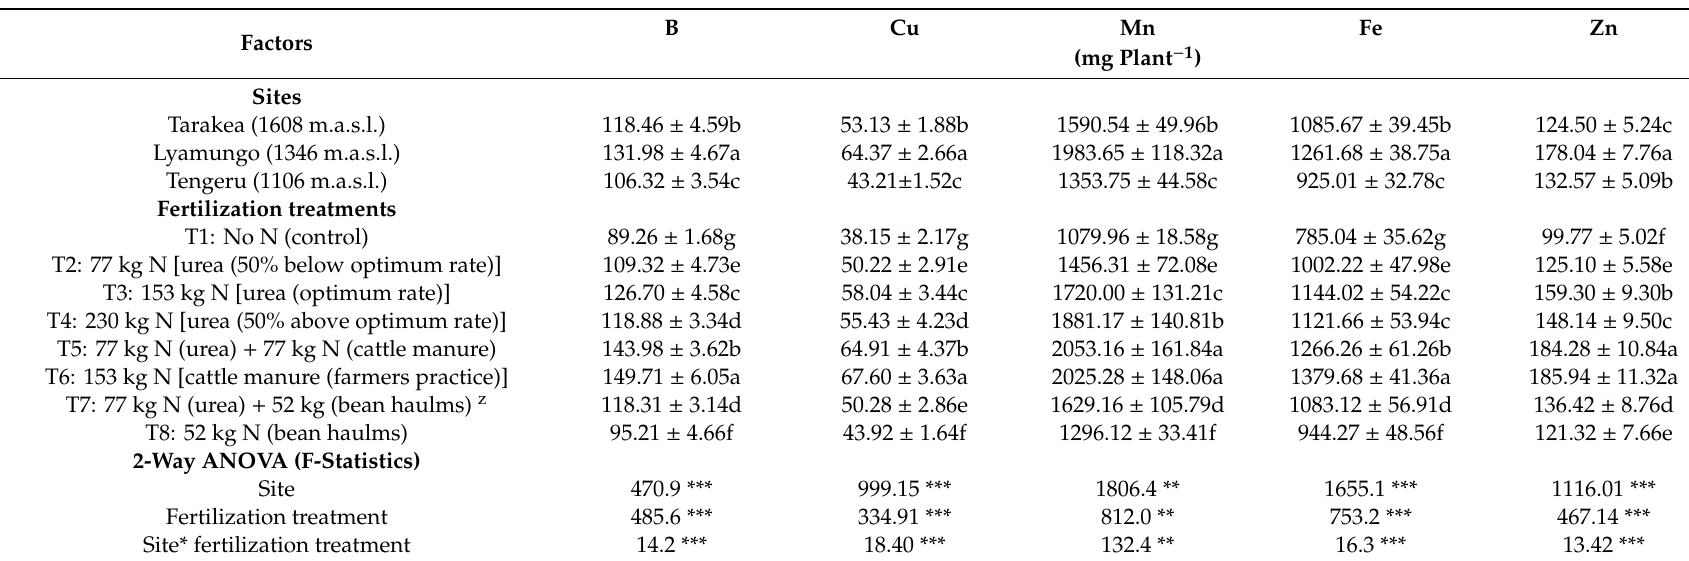
Table 7. E ff ects of fertilization treatments on total nutrient contents in the above ground biomass of Mchare banana at harvest at three sites located along the altitudinal gradients in volcanic soils of the northern highlands,